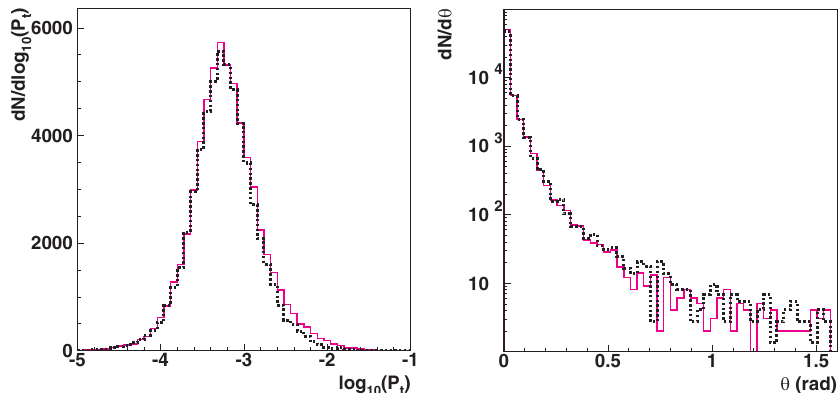
(cid:3) P (cid:4) with P FIG. 6. (Color) log in GeV =c (left plot) and polar angle (right plot) distributions for the Landau-Lifshitz process in t t 10 GUINEA-PIG and BDK (dashed line).